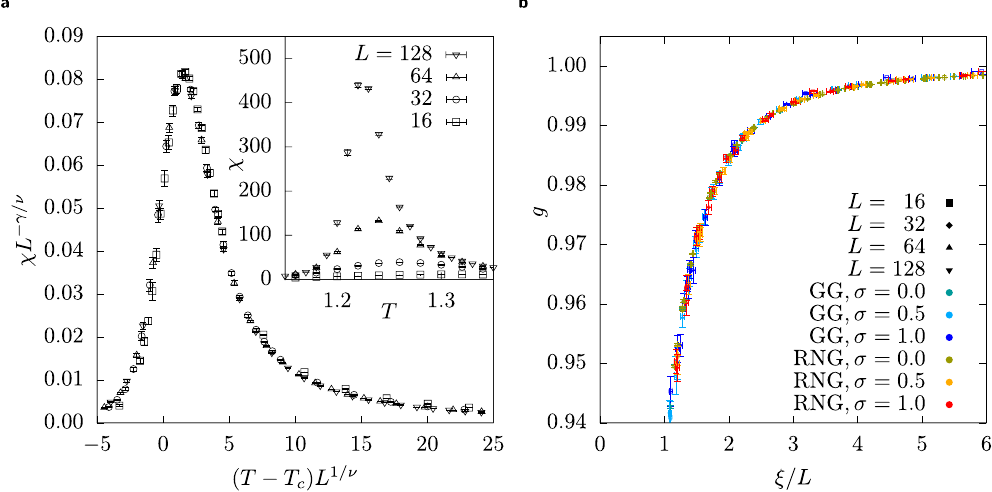
Figure 3. ( a ) Example of a data collapse of the susceptibility χ in regards to the RNG at σ = 1 to get the corresponding critical exponent γ . The same procedure is used on the Binder cumulant g and the magnetisation | m | to determine the critical exponents ν and β and the critical temperature T c (see Table 1). The inset shows the same data with unscaled axes. ( b ) Binder cumulant g as a function of the two-point finite-size correlation function divided by system size L . The data points for different system sizes are drawn with different symbols, while the data points for different graph ensembles are drawn with different colours. All points fall on one curve within